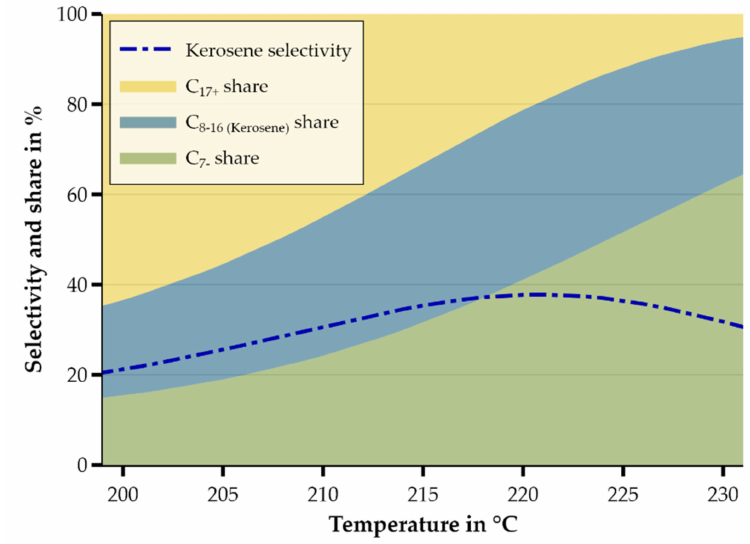
Figure 6. The temperature dependency on selectivity shares and the kerosene range selectivity for a fixed bed reactor with p = 2.5 MPa, GHSV = 5 NL/h/g cat , and H 2 /CO syngas feed ratio = 2.